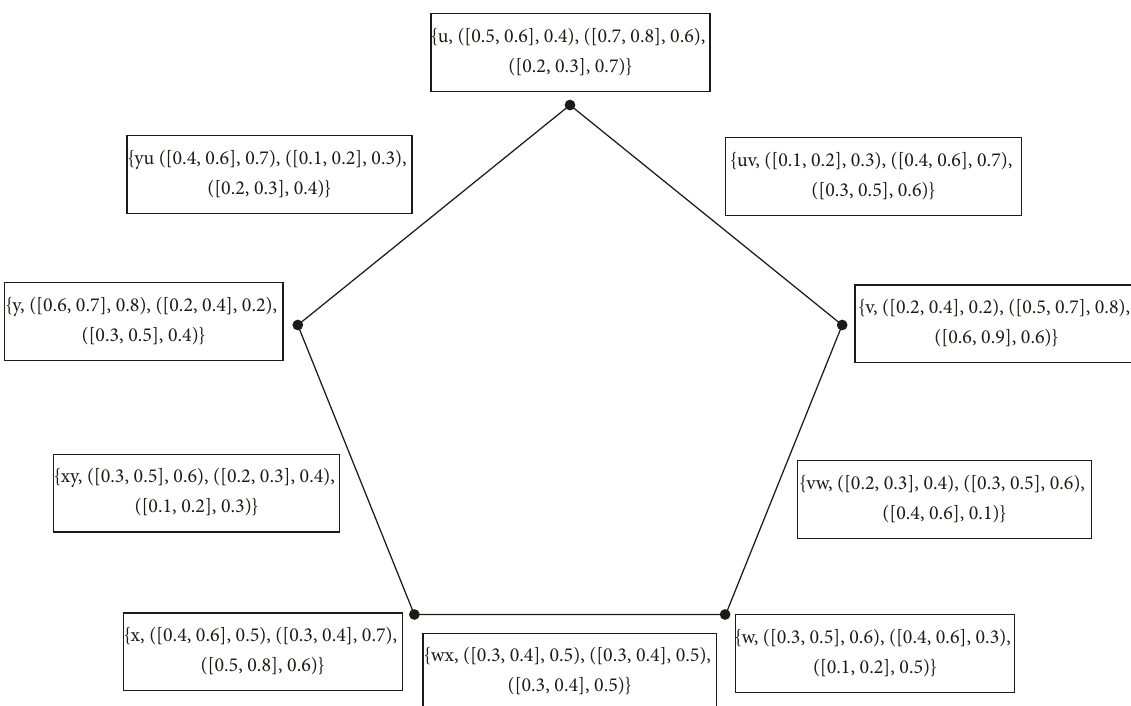
Figure 6: G is both SEI-NCG and